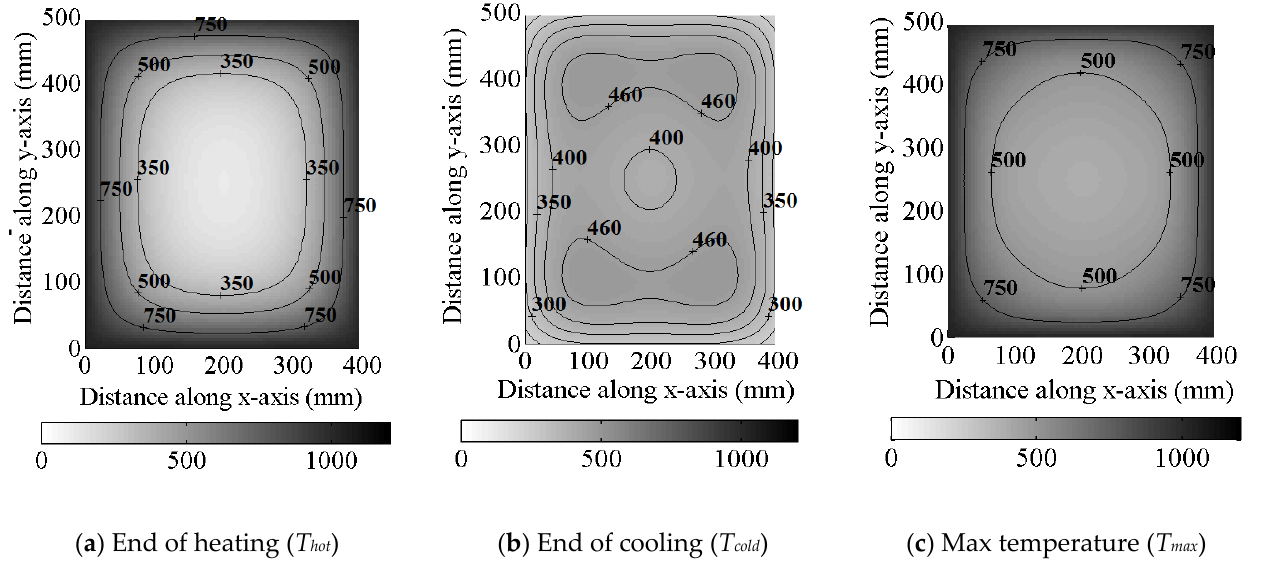
Figure 7. Temperature distribution within the rectangular cross-section of column (R3) at different time increments.